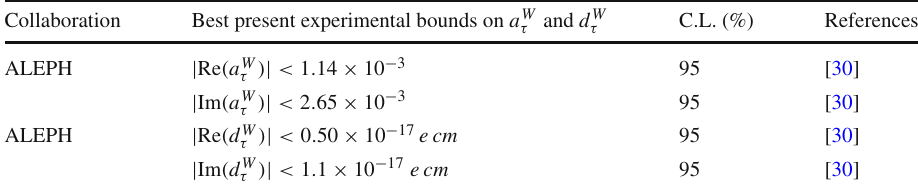
Collaboration Best present experimental bounds on a W τ and d W τ C.L.